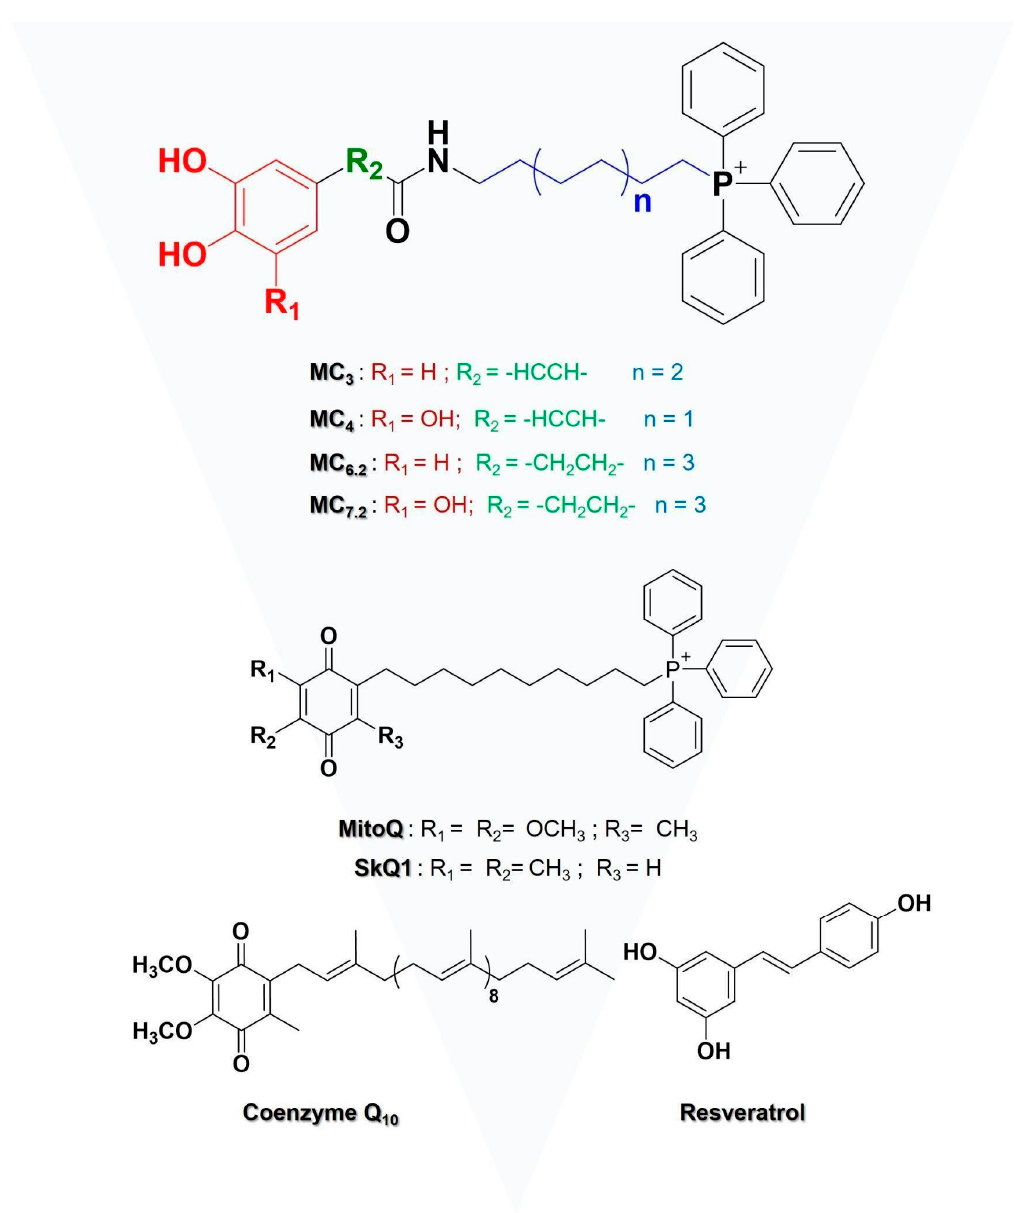
Figure 1. Chemical structures of the mitochondria-targeted (the counterion was omitted for simplicity) and non-targeted antioxidants under study.